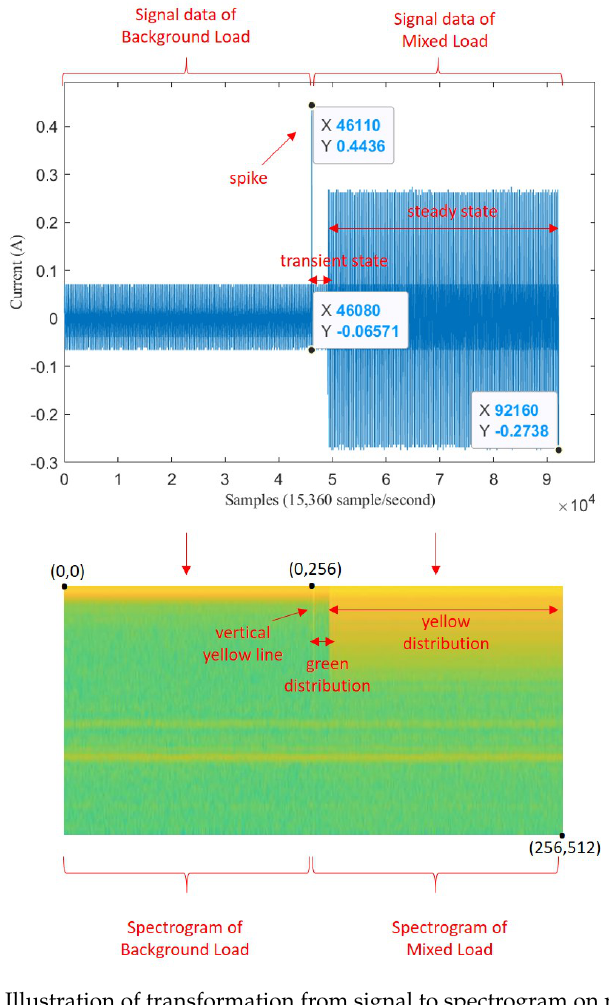
Figure 11. Illustration of transformation from signal to spectrogram on mixed load.